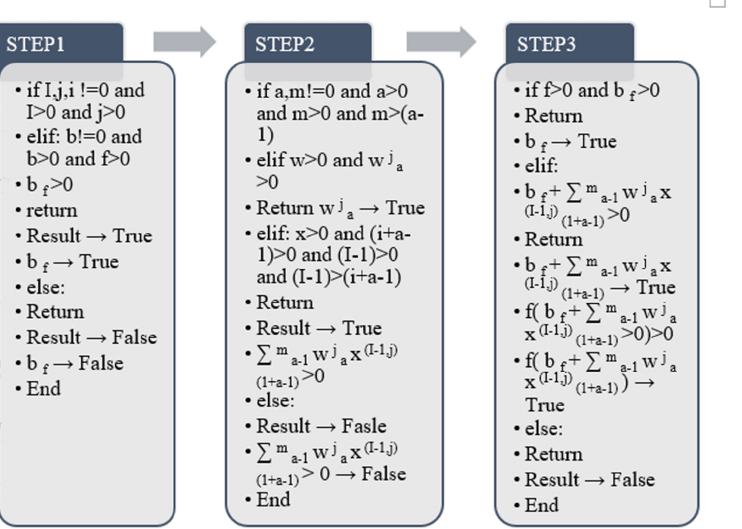
Figure 8. Two-dimensional Convolution Feature Extraction Algorithm (Convolutional Layer).